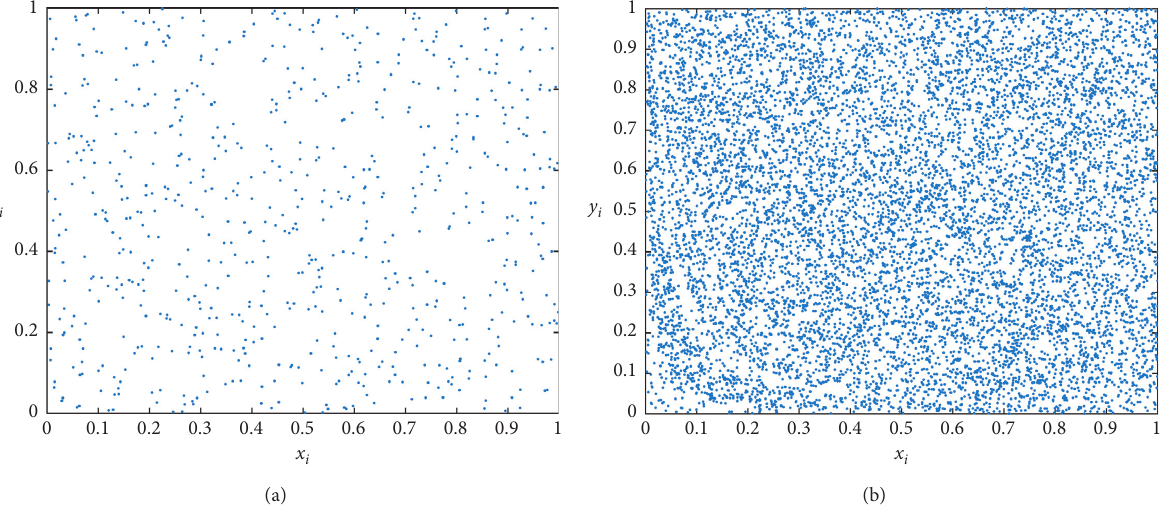
Figure 7: The phase diagrams of two maps. (a) Digital baker map; (b) iteration-time combined digital baker map.